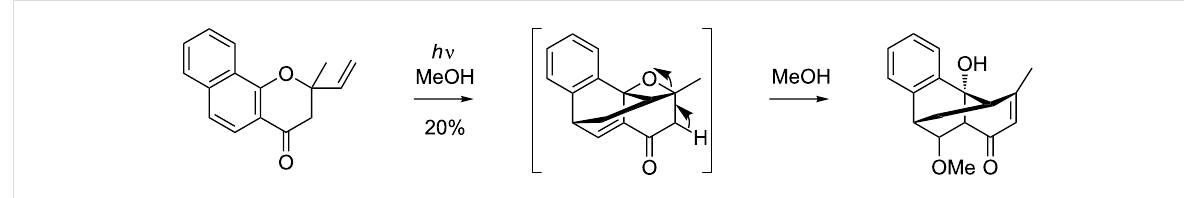
Scheme 33: Intramolecular photocycloaddition affording multicyclic compounds via [4 + 2].